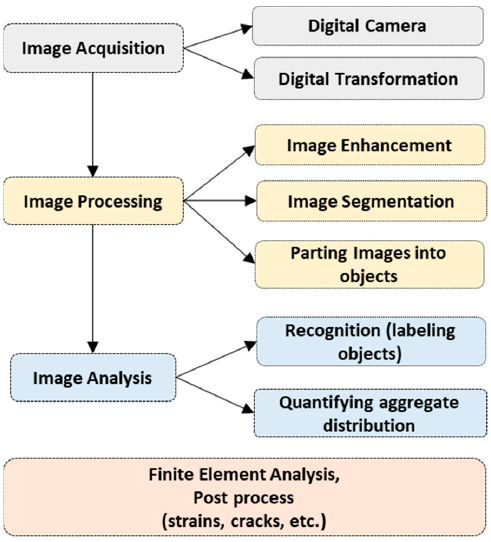
Figure 13. Digital image analysis process for microstructure modeling.